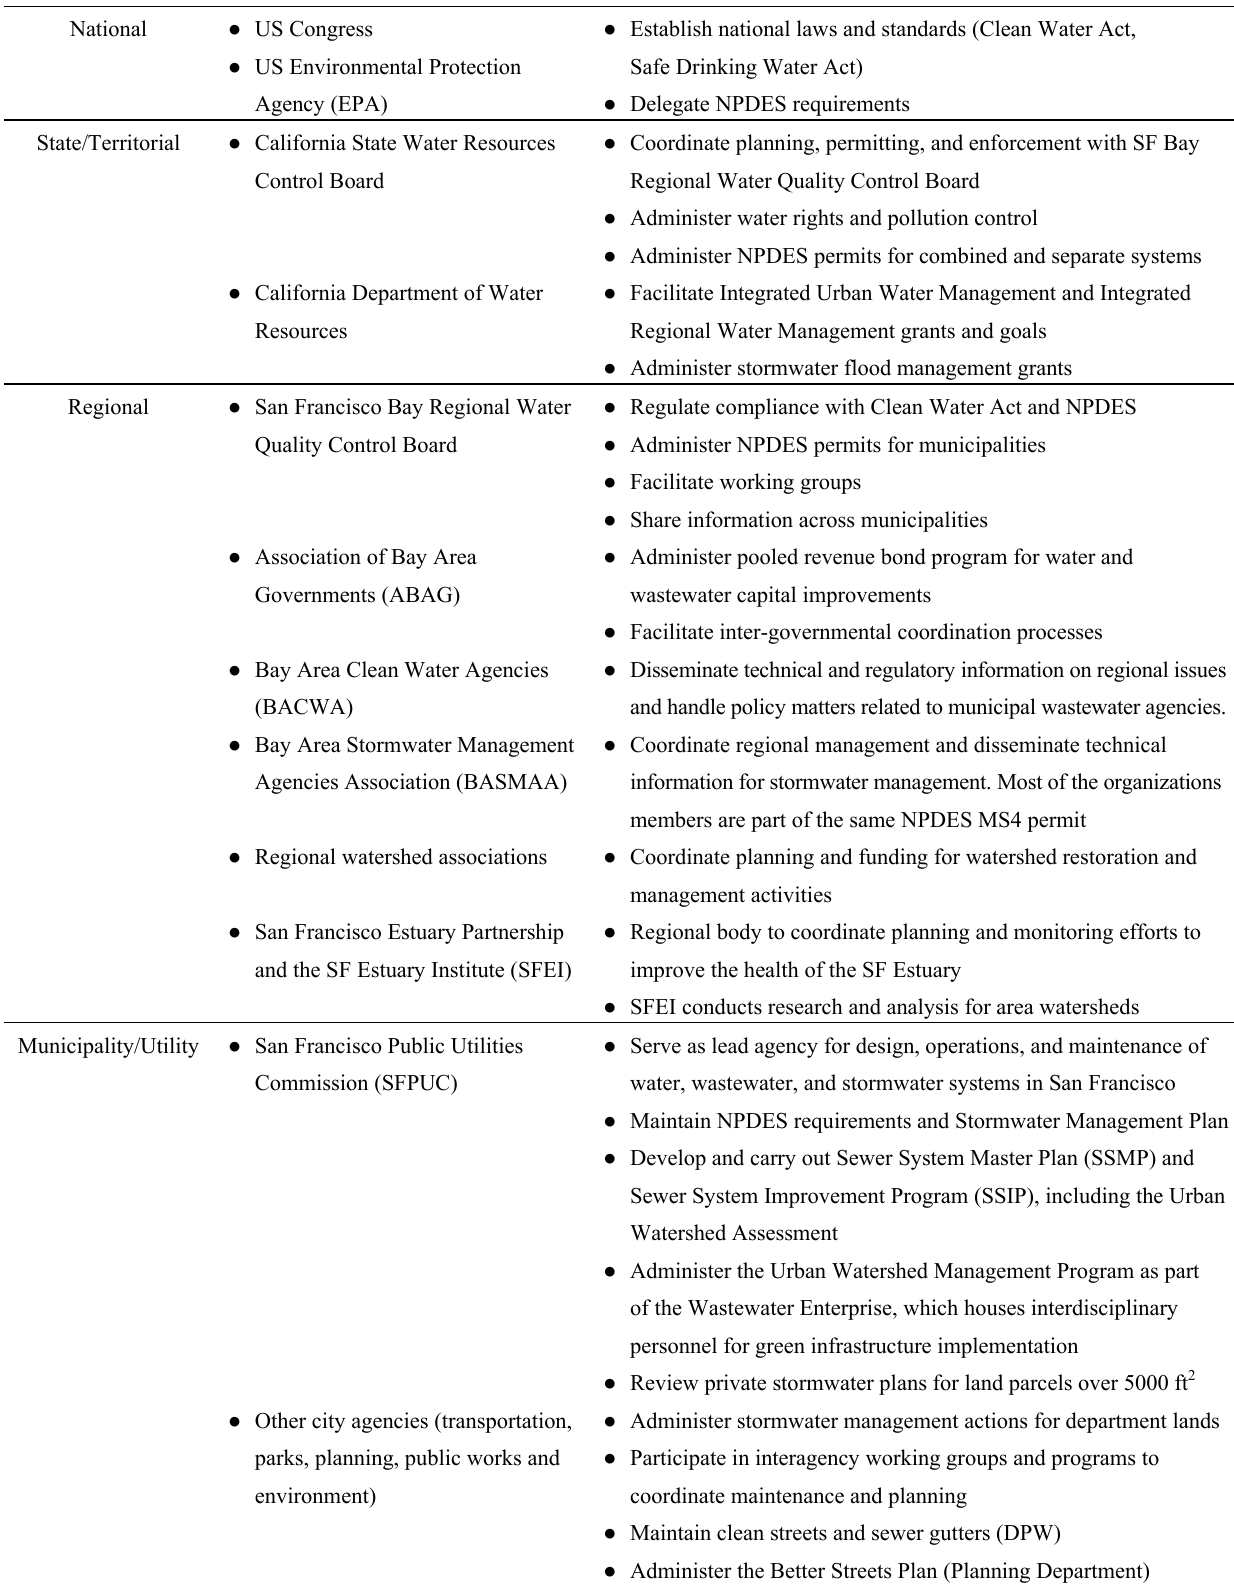
Table 4. Stormwater management in San Francisco: governance levels and